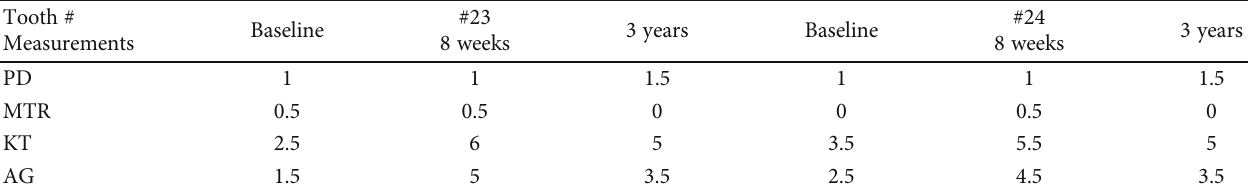
Table 1: Clinical buccal measures of the donor area at baseline, at eight weeks, and at three years. Tooth #